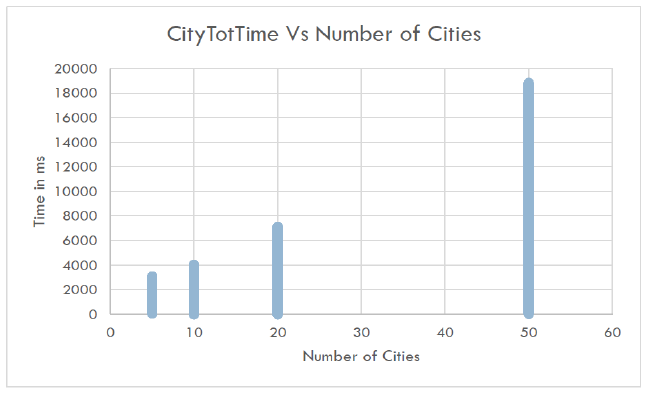
Fig. 8. Time vs Number of cities generated -